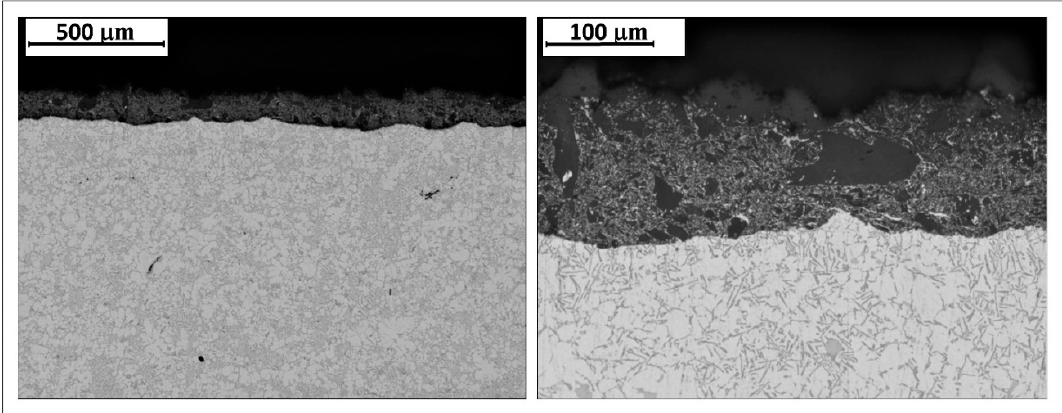
Figure 13. Collage of various micrographs of the transverse sections of the hollowed crossbeam.